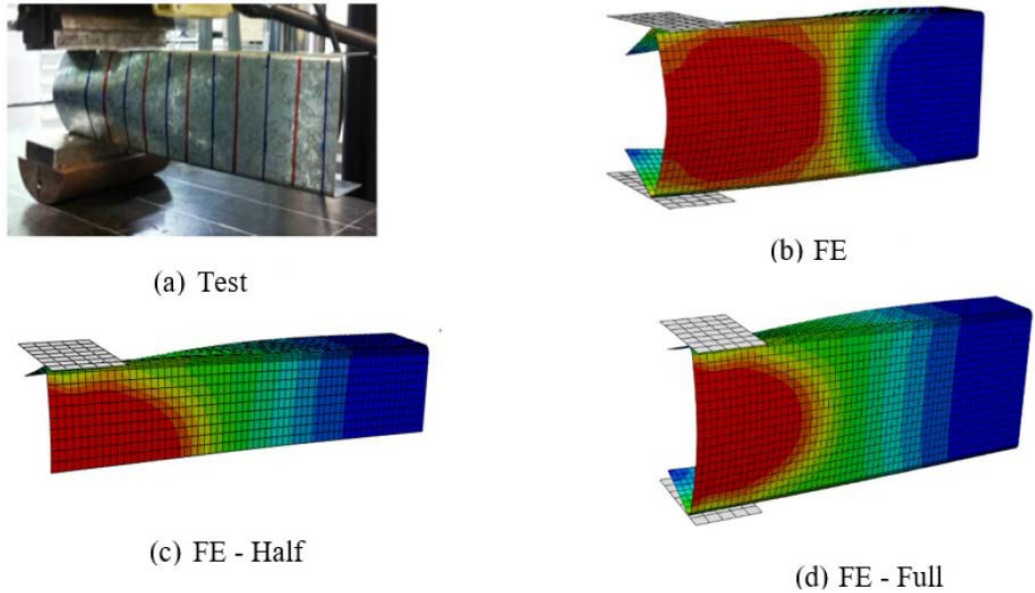
Figure 12. Failure mode comparison for full and half models of ETF-UC10012 with 50 mm bearing plate [21].